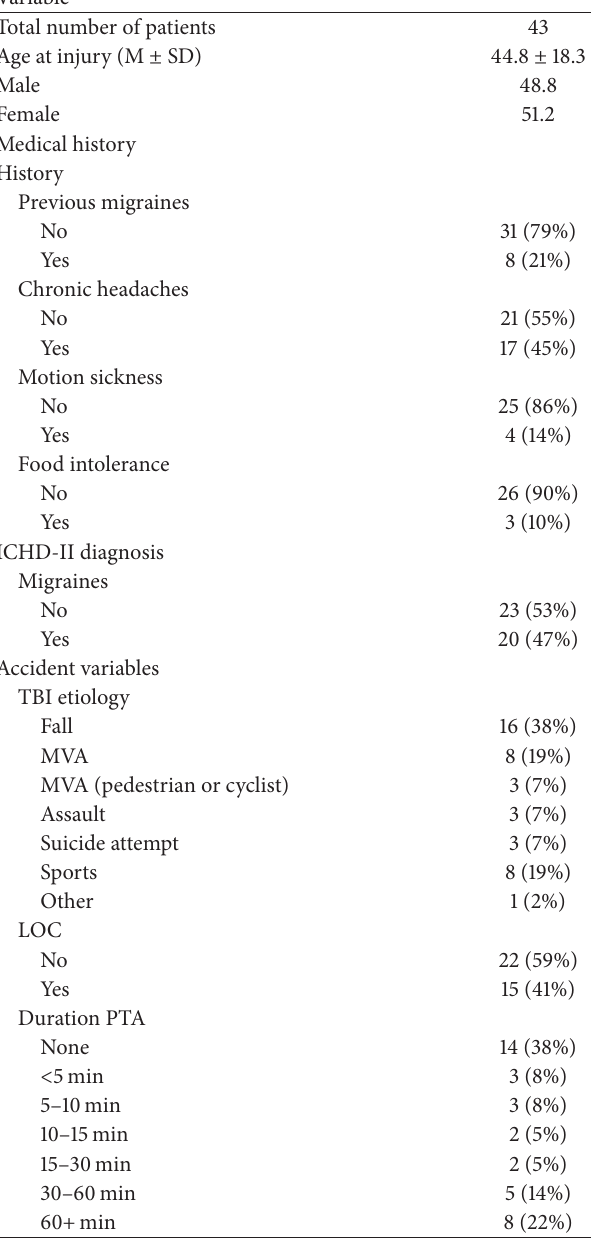
Table 1: Demographics and previous medical